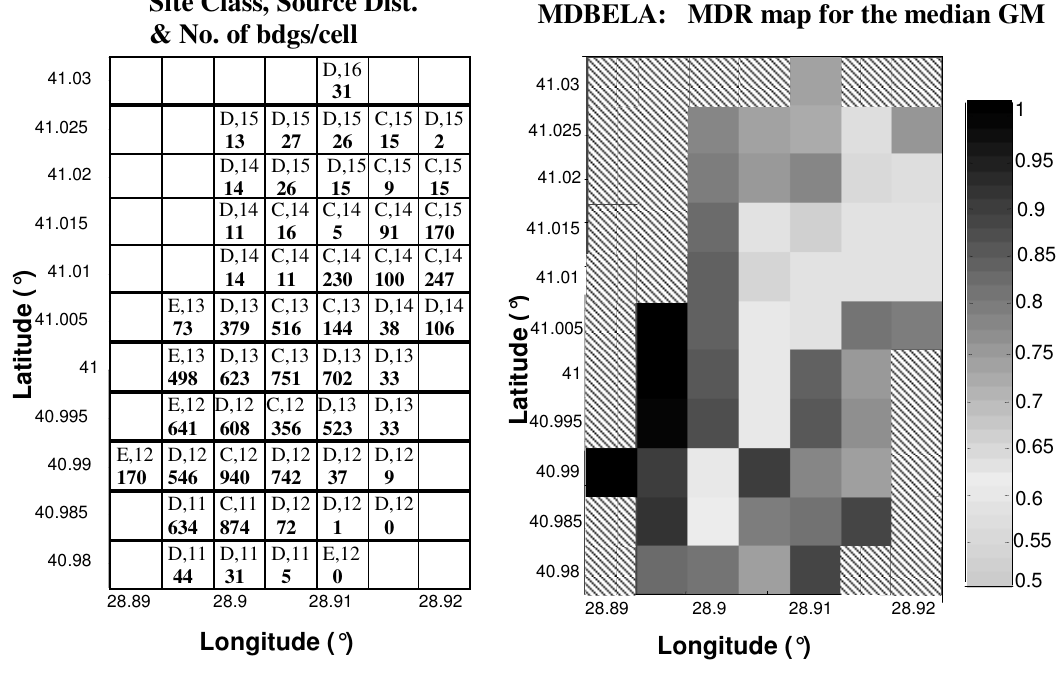
Fig. 8. Left: Geocell NEHRP Site Class (C, D or E); distance from the closest source (in km); and no. of buildings in that geocell, right: Mean Damage Ratio (MDR) per geocell for MDBELA given Bal et al. (2008a) are damage ratios for Turkish settings. Figure 8. Left:-Geocell NEHRP Site Class (C, D or E), Distance from the closest source (in 3 km) and no. of buildings in that geocell, Right:- Mean Damage Ratio per geocell for 4 method (MADRS) was also utilised for SELENA. Erdu- MDBELA given Bal et al. (2008a) damage ratios for Turkish settings 5 ran et al. (2010) showed, however, that virtually no differ- ence in damage states is seen between CSM and MADRS.